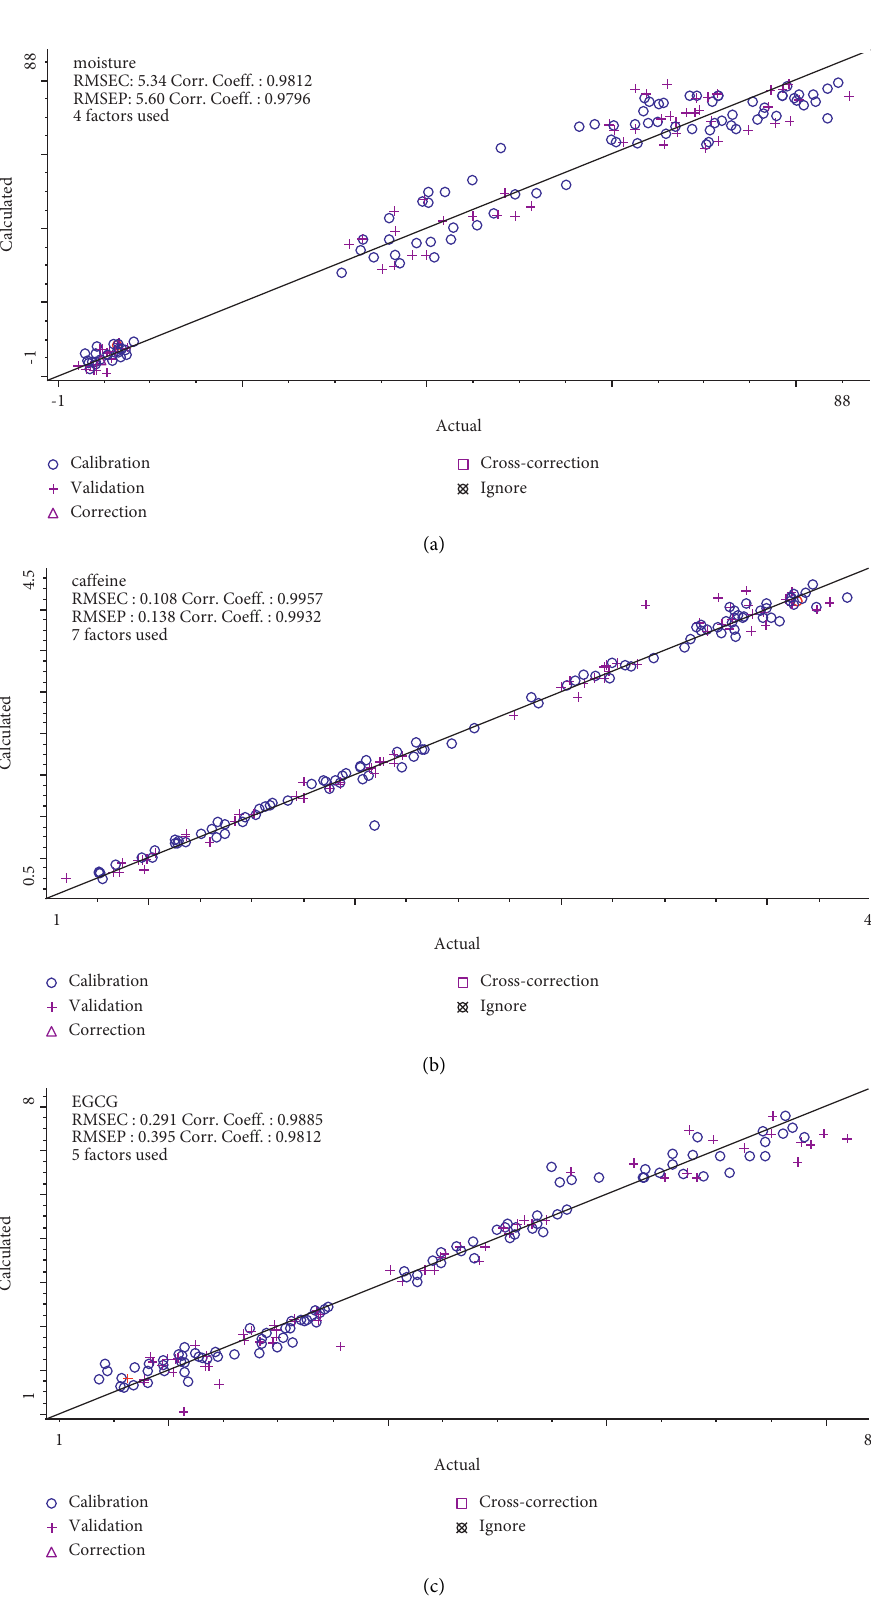
Figure 7: Prediction results of the three partial least squares models: (a) moisture, (b) caffeine, and (c)